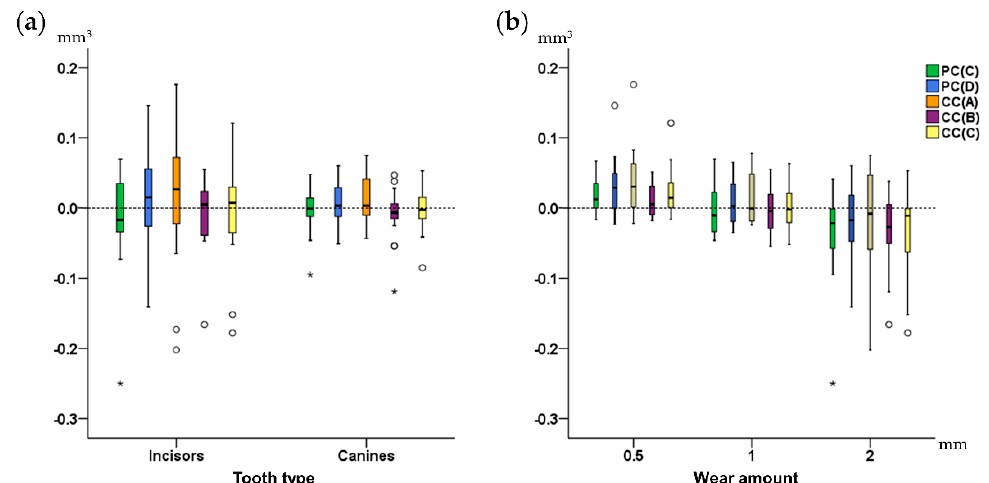
Figure 6. Box plots showing on the Y-axis the difference of each technique from the gold standard technique in tooth wear measurements, (a) by tooth type, and (b) by amount of tooth wear. The upper limit of the black line represents the maximum value, the lower limit the minimum value, the box the interquartile range, and the horizontal black line the median value (trueness). Outliers are shown as black circles or asterisks, in more extreme cases, with a step of 1.5 × IQR (interquartile range). Zero value (dashed horizontal line) indicates perfect agreement with the gold standard. The vertical length of each plot indicates precision. PC: partial crown; CC: complete crown.